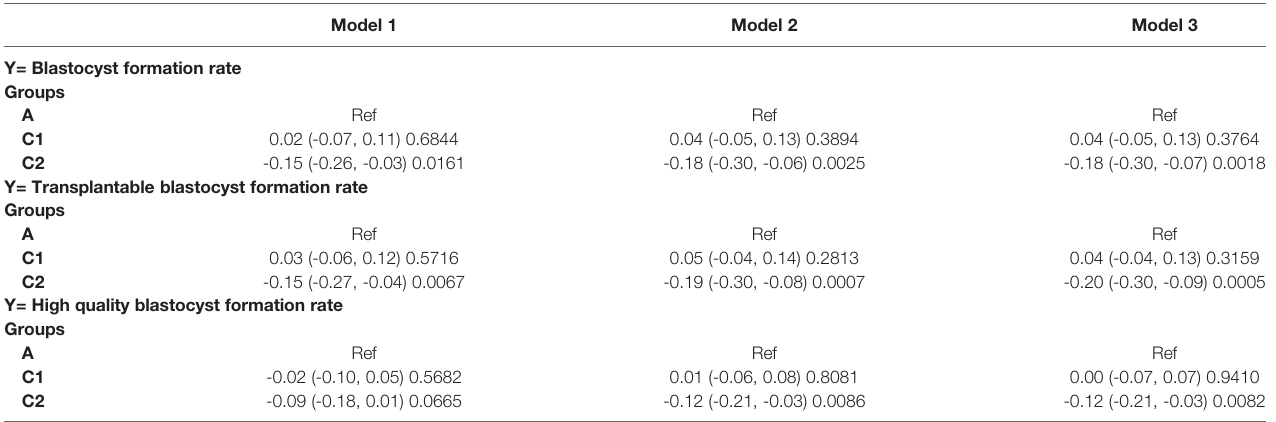
TABLE 5 | Multivariate regression analysis to explore the in fl uence of grade IV embryos on the development of other embryos in the group culture system.